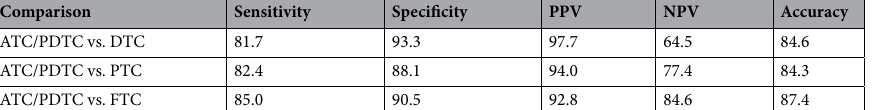
Table 2. Ability of radiomics feature analysis to distinguish ATC/PDTC from DTCs > 3.0 cm based on contrast-enhanced CT. Data are percentages. ATC/PDTC, anaplastic thyroid carcinoma/poorly